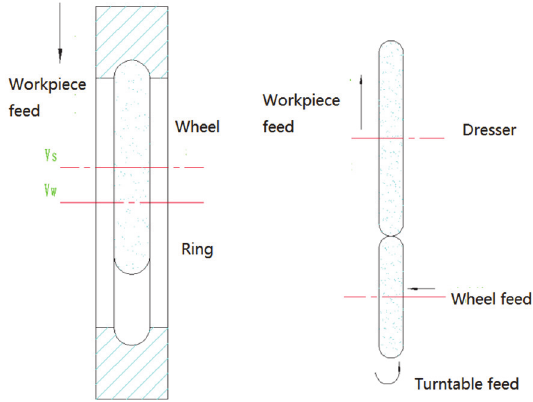
. 114 Figure 1. Grinding wheel dressing method. Figure 2. Grinding wheel dressing method. 115